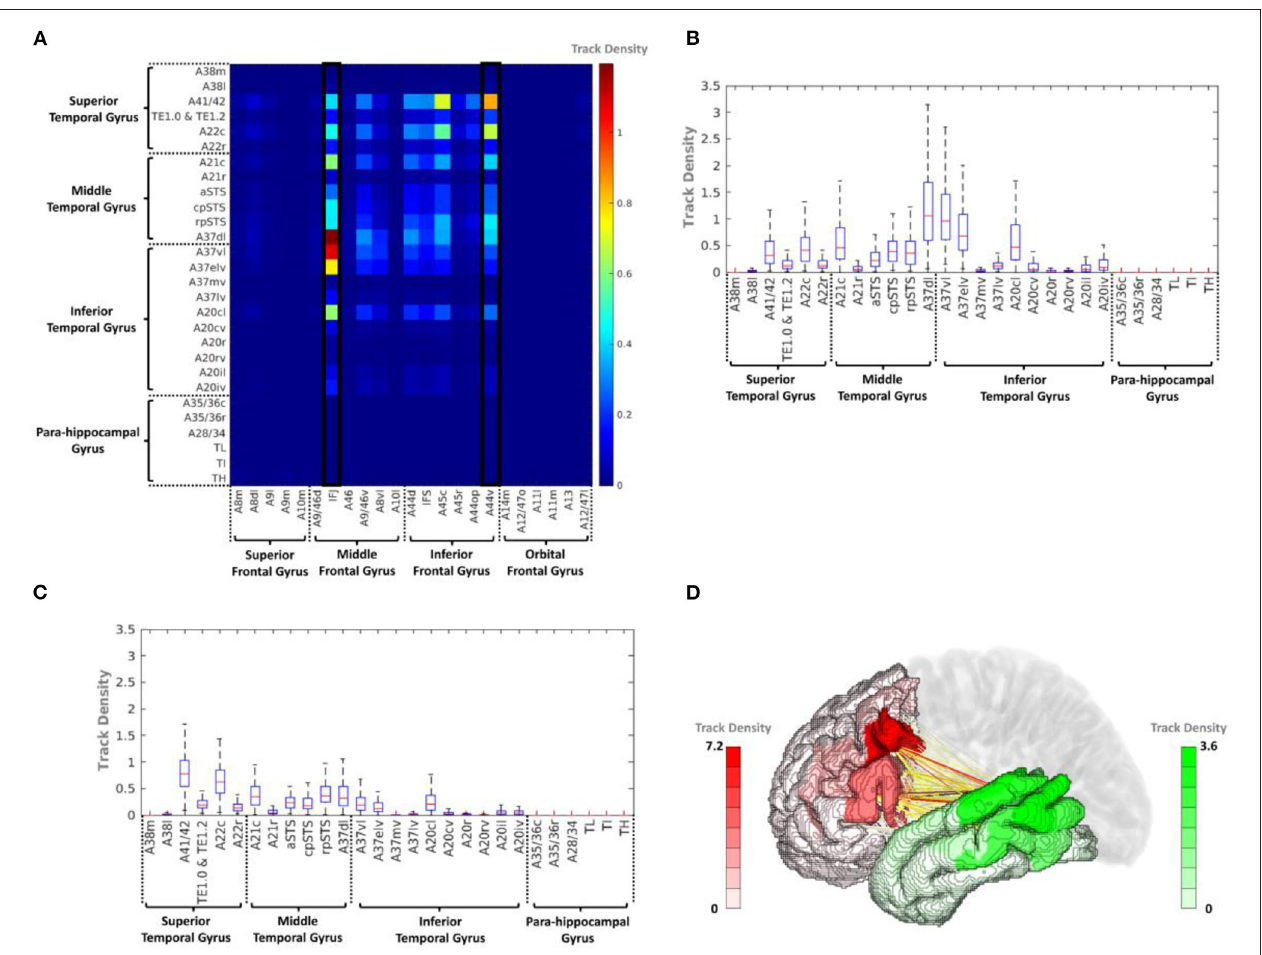
FIGURE 5 | (A) Average track-density matrix of the acquired fiber tracts from the PFC–TC. (B) Box-and-whisker plot showing the IFJ–TC connectivity specifically for the regions indicated in (A) . (C) Box-and-whisker plot showing the A44v–TC connectivity specifically for the regions indicated in (A) . (D) Three-dimensional visualization of track density in PFC–TC connectivity. A8m, medial area 8; A8dl, dorsolateral area 8; A8vl, ventrolateral area 8; A9l, lateral area 9; A9m, medial area 9; A9/46d, dorsal area 9/46; A10m, medial area 10; A10l, lateral area 10; A11l, lateral area 11; A11m, medial area 11; A12/47l, lateral area 12/47; A12/47o, opercular area 12/47; A13, area 13; A14m, medial area 14; A21c, caudal area 21; A21r, rostral area 21; A22c, caudal area 22; A22r, rostral area 22; A37dl, dorsolateral area 37; A38l, lateral area 38; A38m, medial area 38; A41/42, area 41/42; A44d, dorsal area 44; A44op, opercular area 44; A44v, ventral area 44; A45c, caudal area 45;